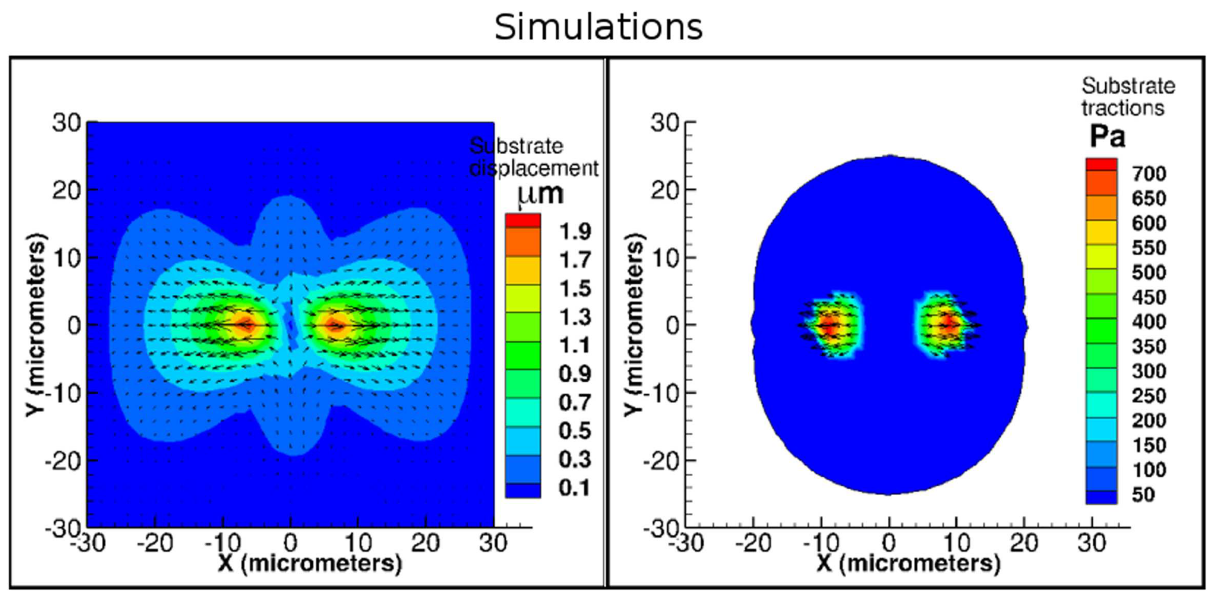
Fig 3. Comparison of simulations to cell spreading in a confined environment. Our simulations are shown and corresponding experimental results can be found in Fig 3 of Wang et al. [39] (see center and rightmost panel in middle row.) We illustrate numerically computed substrate displacements and FA tractions. FA traction magnitudes are shown as contours and traction vectors are also illustrated. We note that numerical results comparewell to experiments both qualitativelyand quantitatively. Cell and substrate Young’smodulus: E c = 0.5 kPa, E s = 1 kPa. FA springsdo not